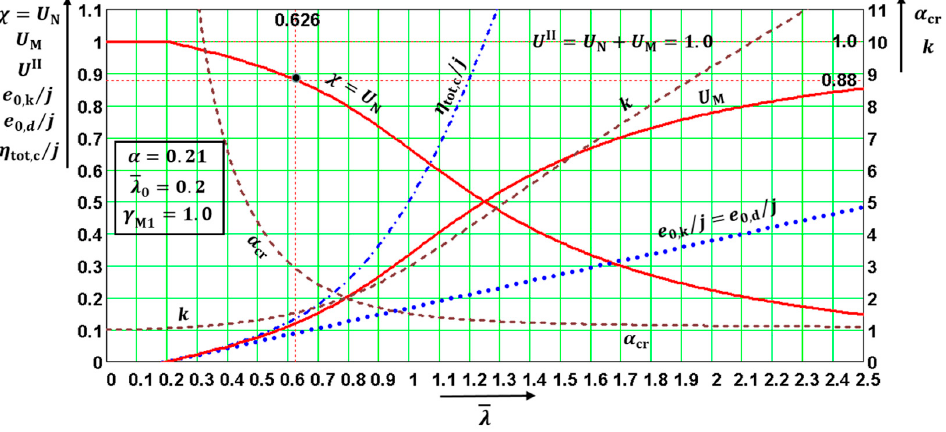
Figure 5. Relevant quantities for α = 0.21, γ M1 = 1.0, and N Ed = N b,Rd = χ Af y / γ M1 . Only Figure 5. Relevant quantities for 𝛼 = 0.21, 𝛾 (cid:2897)(cid:2869) = 1.0 , and 𝑁 (cid:2889)(cid:2914) = 𝑁 (cid:2912),(cid:2902)(cid:2914) = 𝜒𝐴𝑓 (cid:2935) 𝛾 (cid:2897)(cid:2869) ⁄ . Only quanti- Figure 5. Relevant quantities for 𝛼 = 0.21, 𝛾 (cid:2897)(cid:2869) = 1.0 , and 𝑁 (cid:2889)(cid:2914) = 𝑁 (cid:2912),(cid:2902)(cid:2914) = 𝜒𝐴𝑓 (cid:2935) 𝛾 (cid:2897)(cid:2869) ⁄ . Only quanti- Figure 5. Relevant quantities for 𝛼 = 0.21, 𝛾 (cid:2897)(cid:2869) = 1.0 , and 𝑁 (cid:2889)(cid:2914) = 𝑁 (cid:2912),(cid:2902)(cid:2914) = 𝜒𝐴𝑓 (cid:2935) 𝛾 (cid:2897)(cid:2869) ⁄ . Only quanti- quantities α cr , k , and e 0,d / j are functions of safety factor γ M1 . ties 𝛼 (cid:2913)(cid:2928) ,𝑘,and 𝑒 (cid:2868),(cid:2914) 𝑗⁄ are functions of safety factor 𝛾 (cid:2897)(cid:2869) . ties 𝛼 (cid:2913)(cid:2928) ,𝑘,and 𝑒 (cid:2868),(cid:2914) 𝑗⁄ are functions of safety factor 𝛾 (cid:2897)(cid:2869) . ties 𝛼 (cid:2913)(cid:2928) ,𝑘,and 𝑒 (cid:2868),(cid:2914) 𝑗⁄ are functions of safety factor 𝛾 (cid:2897)(cid:2869) .